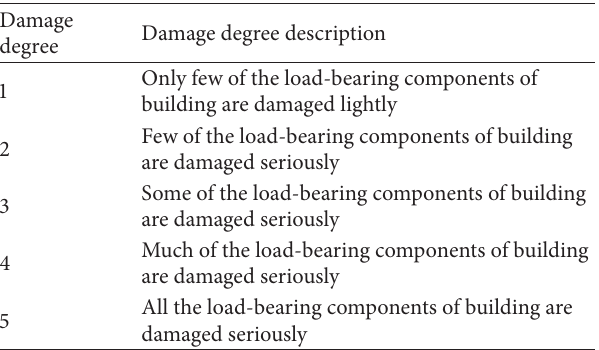
Table 2: The damage degree description of ground building. Damage